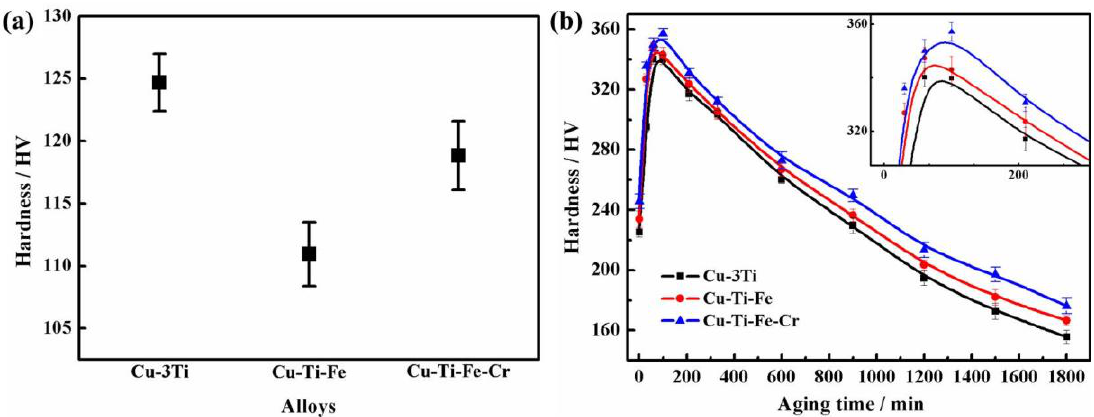
Figure 3 . Variation of Hardness of the three alloys. ( a ) In the solution-treated condition; ( b ) aging at 450 °C, after the cold-rolling.